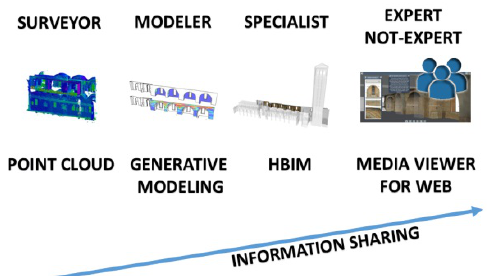
Figure 3. The digital workflow applied to the research case